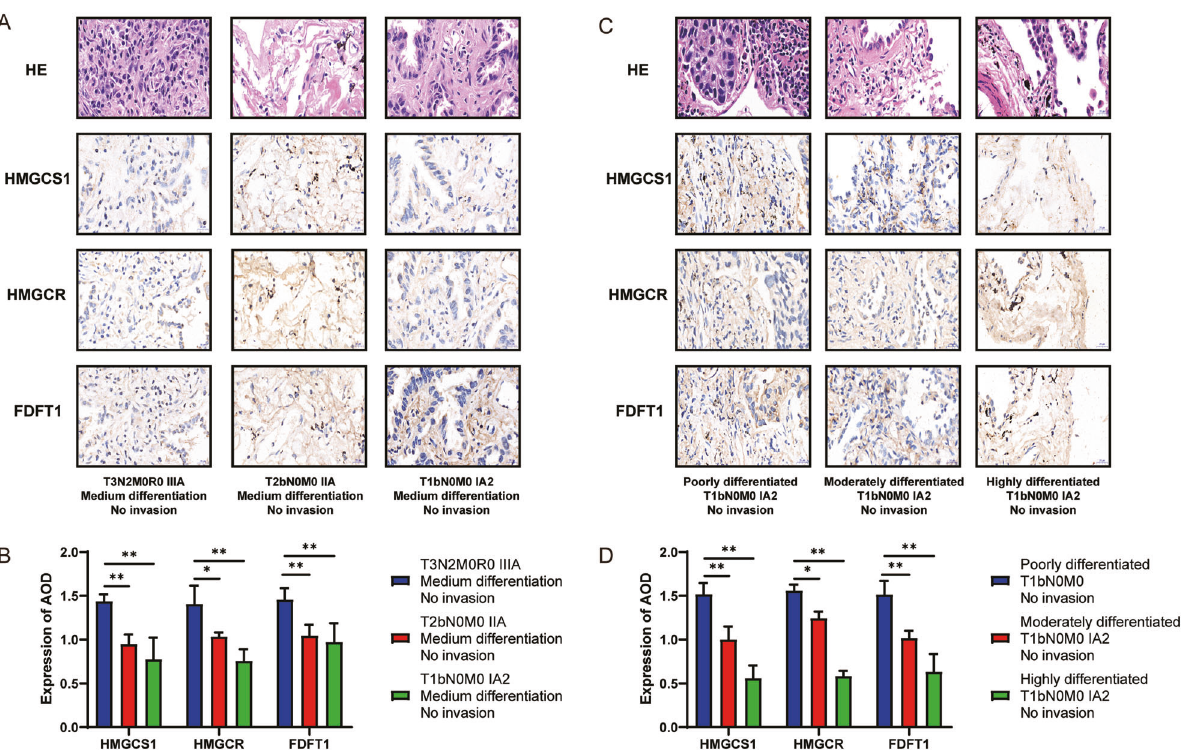
Fig. 6 Correlation of malignant NSCLC with the expression of key genes in the MVA pathway. HMGCS1, HMGCR, and FDFT1 protein expression in tumor tissues of p53 wild-type NSCLC patients with different cancer stages by IHC staining ( A ) (×40 magni fi cation) and the bar graph corresponding to A of their expression ( B ). p53 wild-type NSCLC cancers with different degrees of differentiation by HE, HMGCS1, HMGCR, and FDFT1 by IHC staining ( C ) (×40 magni fi cation) and the bar graphs of their expression ( D ). AOD values were measured from positive areas of three randomly selected different fi elds of view (mean ±SD), ns not signi fi cant, * P <0.05 and ** P